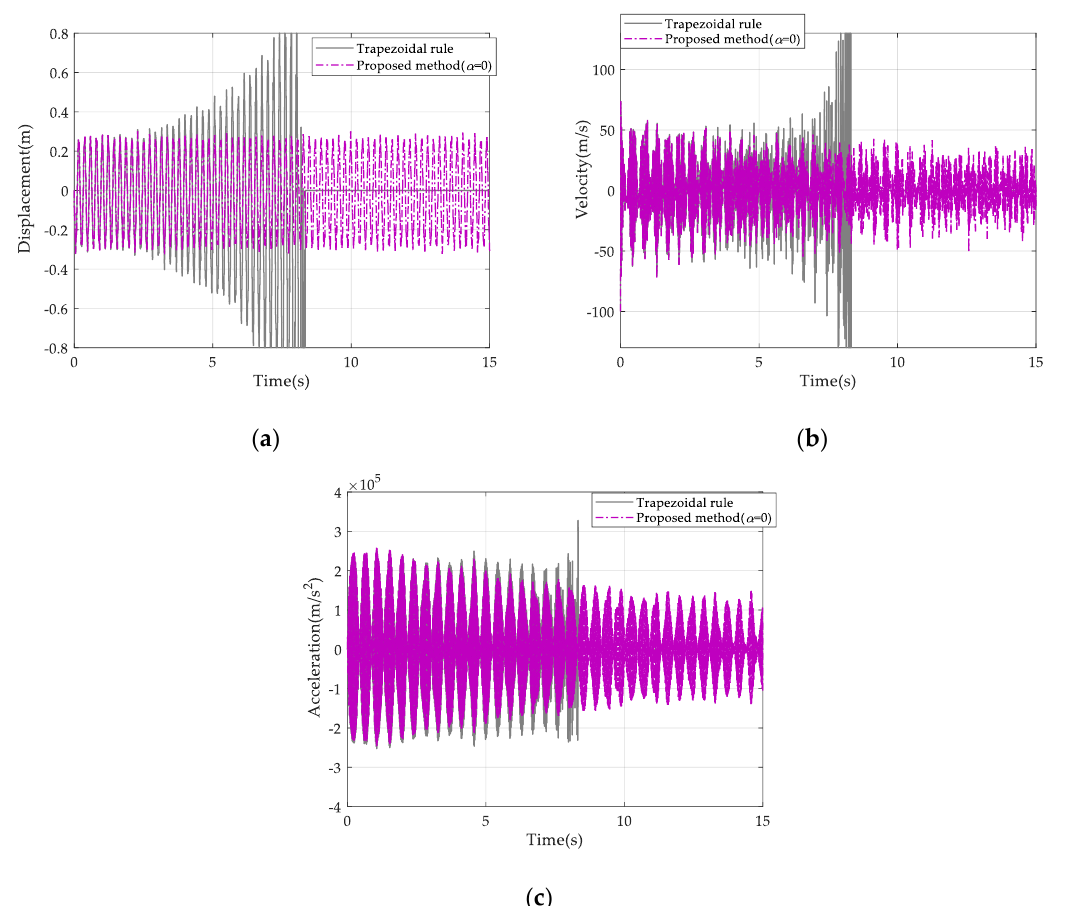
Figure 13. Vertical response of Point A with the trapezoidal rule and the proposed method when ∆ t = 0.01 s: ( a ) Displacement response. ( b ) Velocity response. ( c ) Acceleration response.